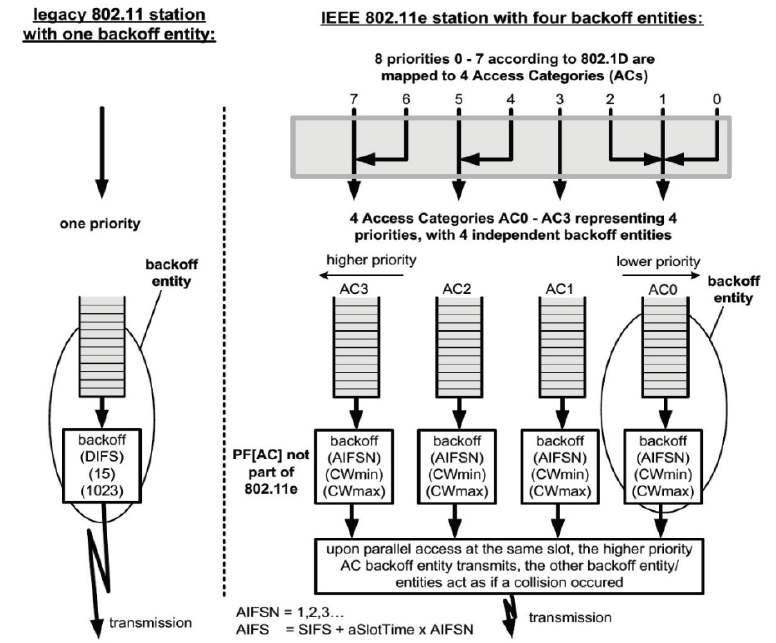
Fig. 2. Legacy 802.11 station and 802.11e station with four ACs within one